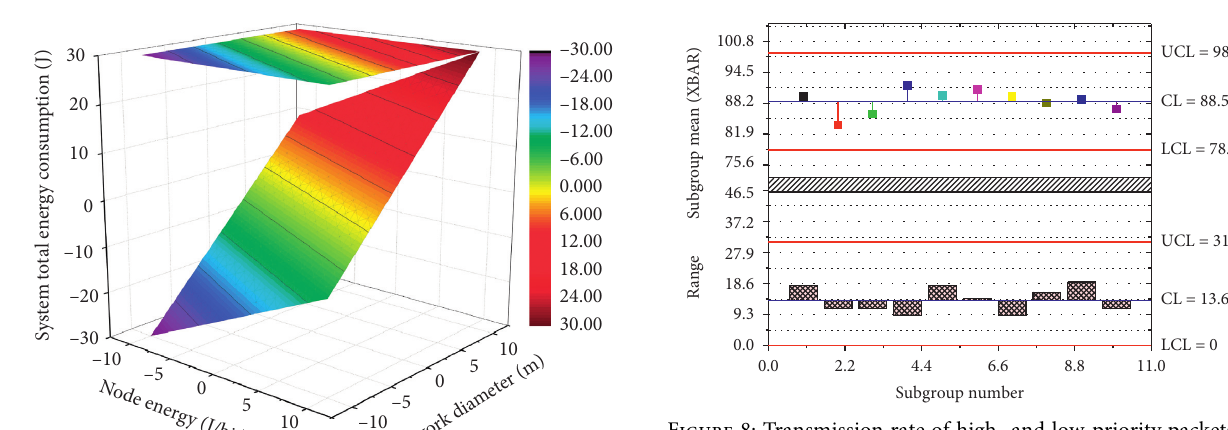
Figure 8: Transmission rate of high- and low-priority packets for MAC protocol in emergency and HCL